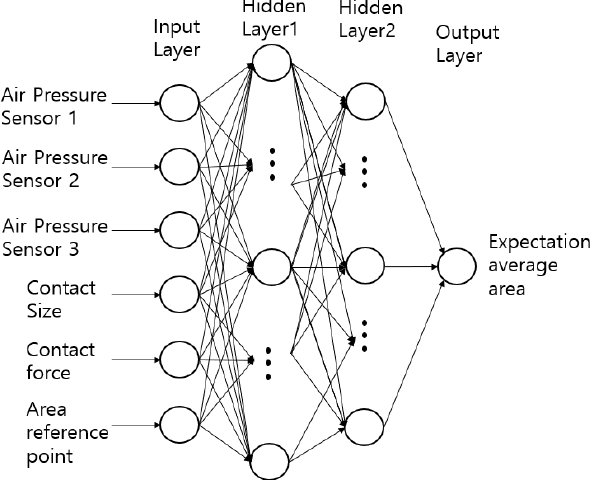
Figure 6. Artificial neural network for contact area training.